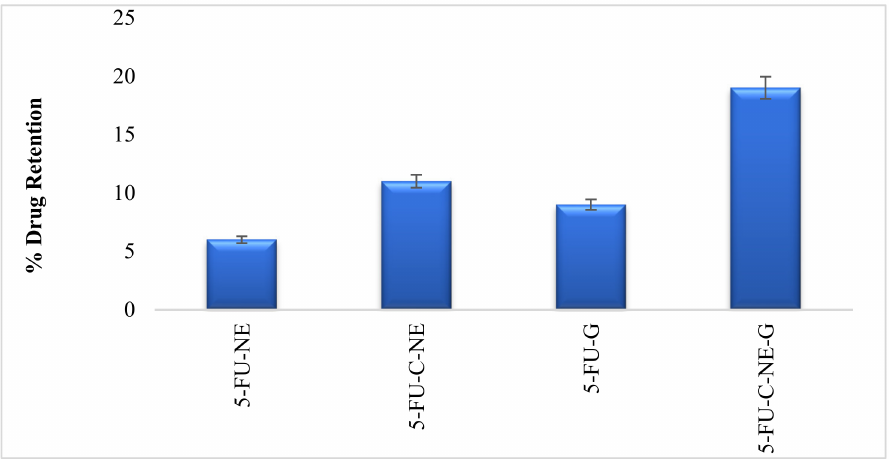
Figure 5. Skin drug